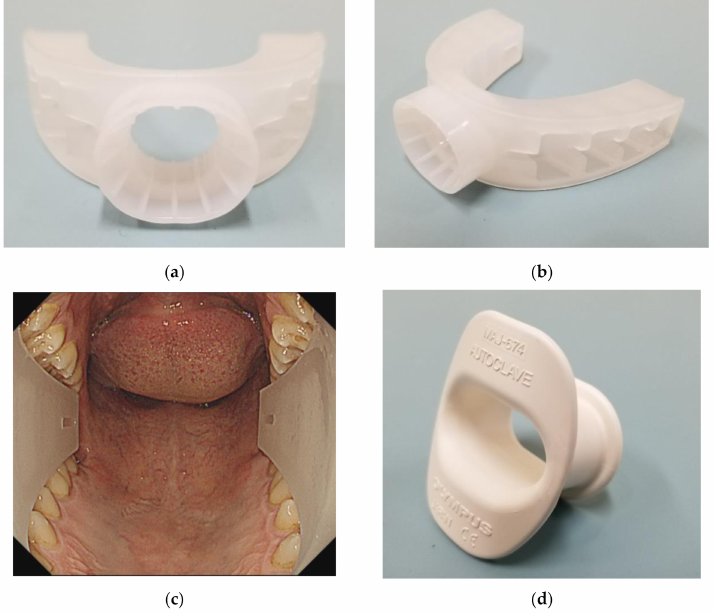
Figure 1. GAGLESS mouthpiece. ( a ) Front view. ( b ) Actual oblique view. ( c ) Oropharyngeal view with the endoscope. GAGLESS mouthpiece was U-shaped along the entire dental arch. ( d ) Conven- tional mouthpiece and actual oblique view. The conventional mouthpiece is held primarily by the front